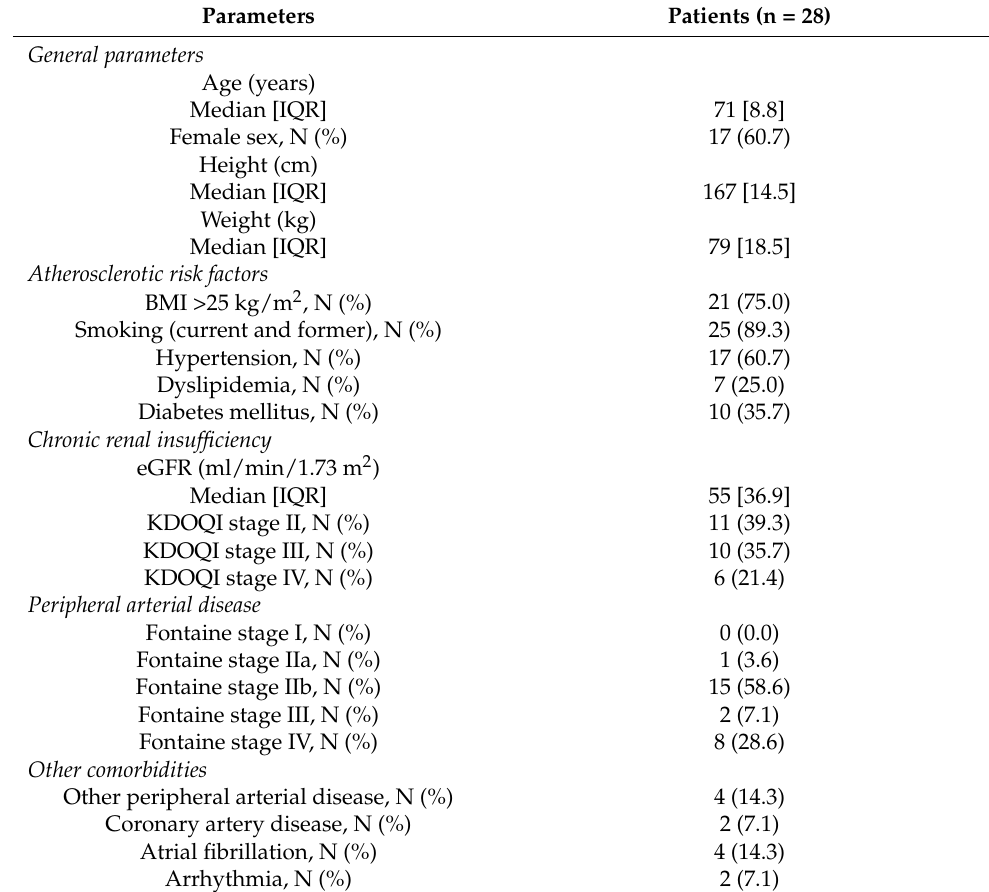
Table 1. Characteristics of the patient population. Continuous variables are described as median and interquartile range (IQR), whereas categorical variables are represented as frequencies and percentages. (BMI: body mass index; eGFR: estimated glomerular filtration rate; KDOQI: Kidney Disease Outcomes Quality